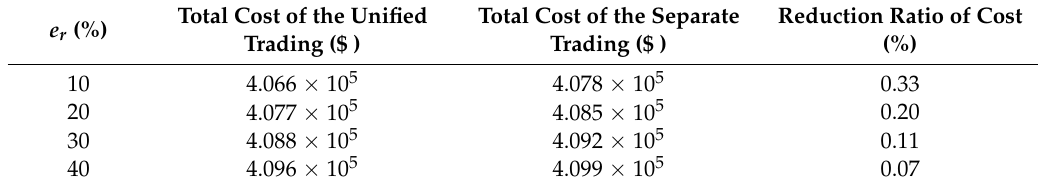
Table 5. Impact of e r on the total purchase